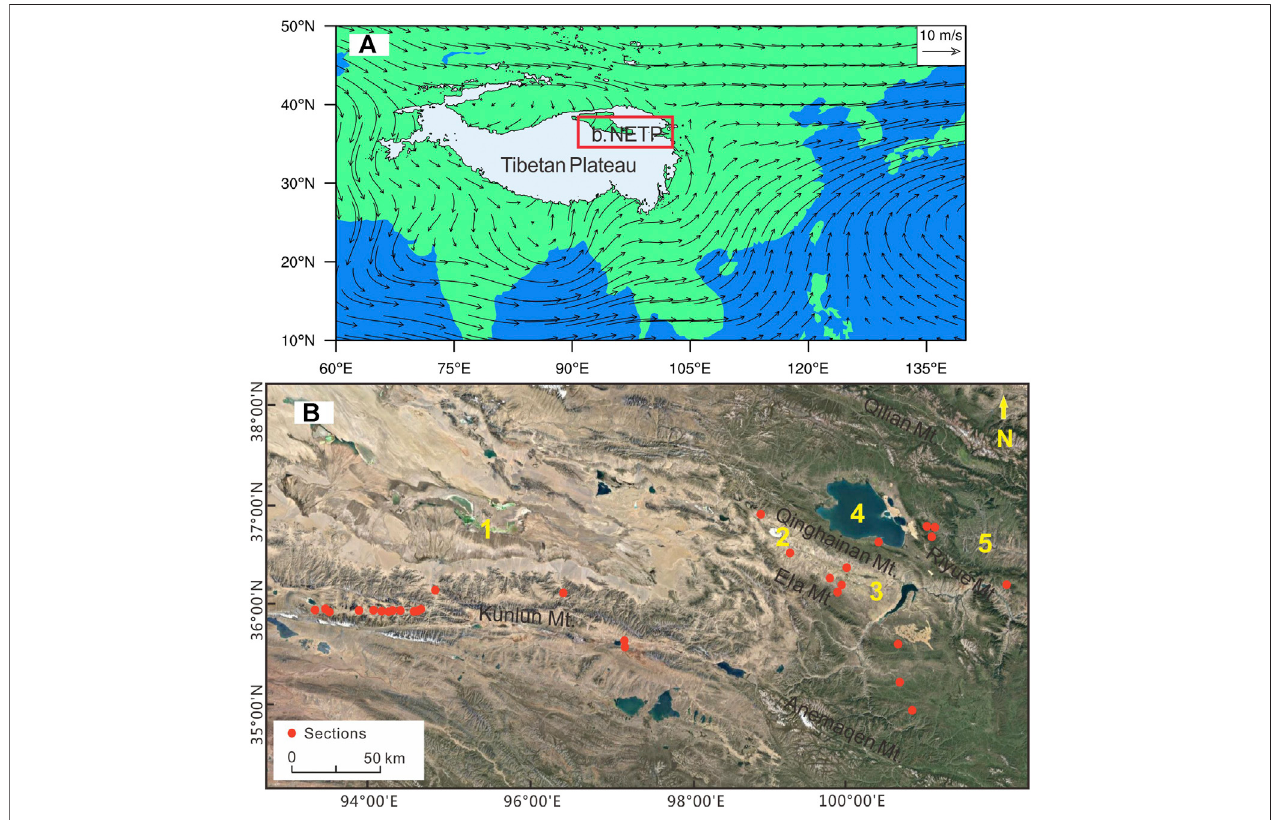
FIGURE1| Location mapshowingthestudyareaandstudysections. (A) Averageatmospheric fl ow fi eldsatthe700 hPaisobarinsummer(modi fi edfromLietal., 2020);theredsquaredenotesthelocationofthestudyarea. (B) EnlargementshowingtheNortheasternTibetanPlateau(NETP)andthemainmountain-basinsystemsin this region (1. Qaidam Basin; 2. Chaka Basin; 3. Gonghe Basin; 4. Qinghai Lake Basin; and 5. Xining Basin).